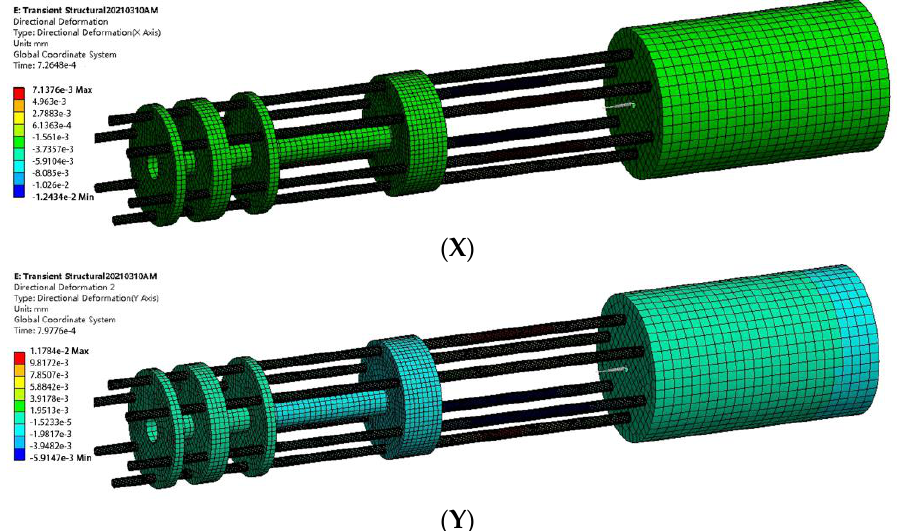
Figure 17. Maximum X (transverse) and Y (vertical) of elastic modulus of 2.2 × 10 11 Pa.